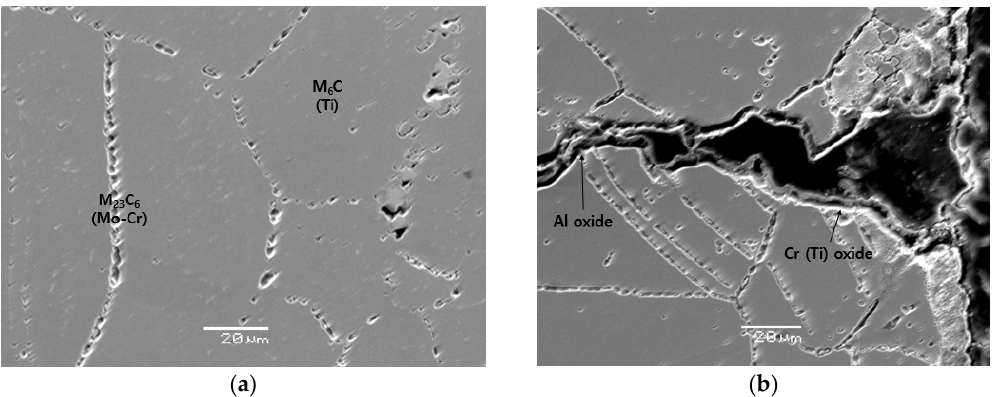
Figure 14. Typical micrographs structure of Alloy 617 fatigued specimens at 950 °C conditions showing: ( a ) precipitates formed on the grain boundary; and ( b ) surface brittle Cr ‐ oxides cracks.